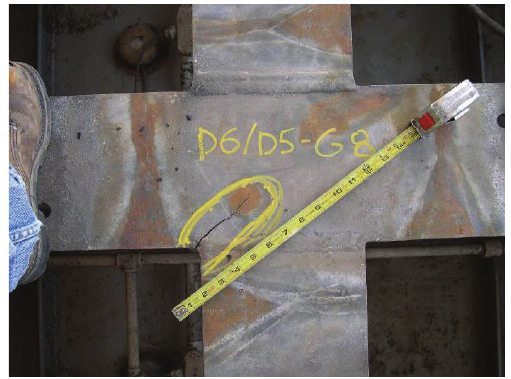
Figure 6: Fatigue crack in diaphragm flanges of miter gate. Figure 7: Fatigue crack in girder flanges of miter